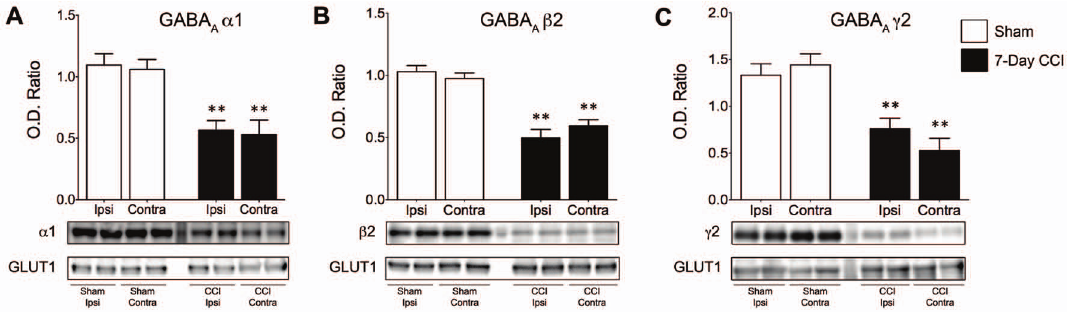
Figure 6. Surface expression of a 1, b 2, and c 2 GABA A receptor subunits is reduced in the BLA of CCI animals 7 days after mild CCI. Western blot for subunits of (A) a 1, (B) b 2, and (C) c 2 subunits, respectively, was performed using biotinylated proteins isolated from the ipsilateral and contralateral sides of Sham and CCI 7-day animals. Group data showing the mean 6 SE of the ratio between each subunit and GLUT1 optical densities. Top panel: representative Western blot for a 1 (A), b 2 (B), and c 2 (C) subunits of GABA A receptors, respectively. Bottom panel: representative Western blot for GLUT1, used as a loading control. Note that surface expression of GABA A a 1, b 2 and c 2 subunits are reduced in CCI animals when compared to Sham animals. * p , 0.01; n=4 for each